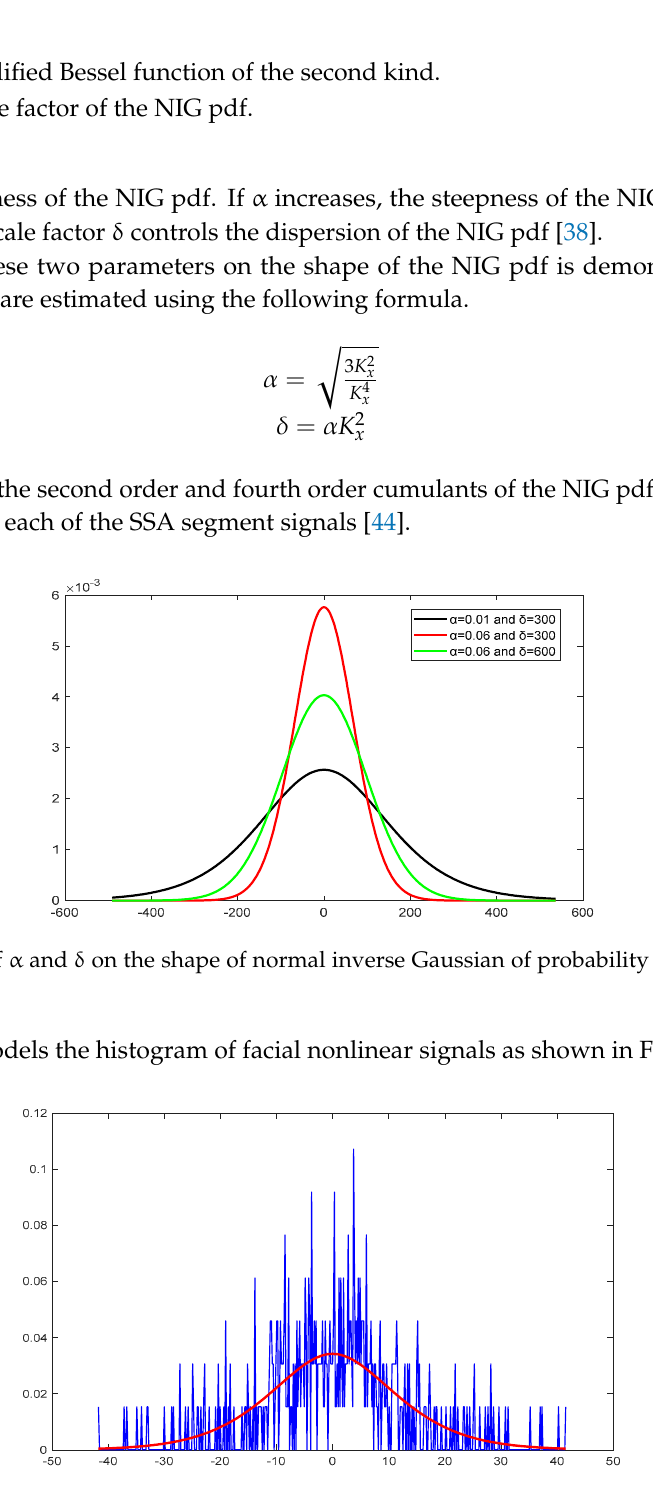
Figure 4. One-dimensional singular spectrum analysis (1D-SSA) of signal.